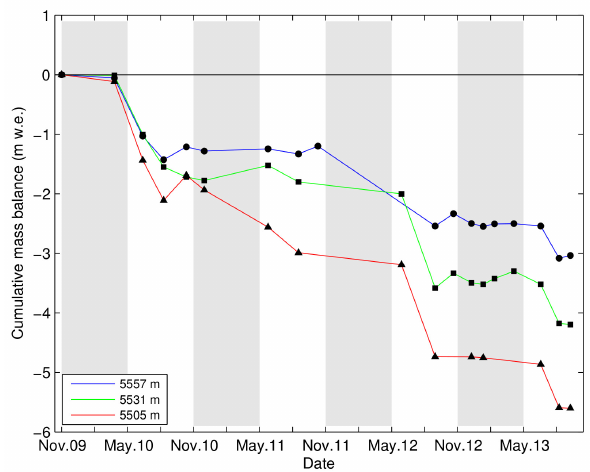
Fig. 8. Cumulative point mass balance recorded at the three lowest stakes (5505 – triangles, 5531 – squares and 5557ma.s.l. – dots) between November 2009 and September 2013 on Pokalde Glacier (lines). Grey areas highlight the main winter season (from Novem- ber to